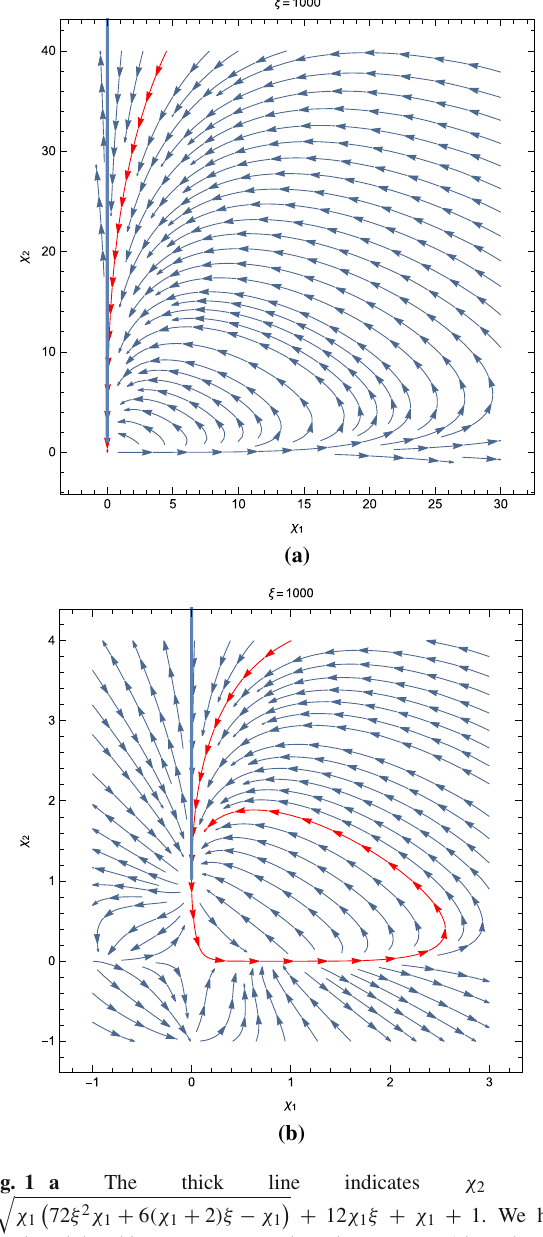
Fig. 1 a The thick line indicates χ 2 = (cid:8) (cid:4) (cid:5) χ ξ + χ + 1. We have + 12 χ + 72 ξ 2 χ 1 + 6 (χ 1 + 2 )ξ − χ 1 1 1 1 mentioned that this curve corresponds to the w ef f = − 1 boundary. As the calculations show, the field flow asymptotically becomes tangent to this line. This graph confirms the de Sitter as a transient attractor path for phantoms. b The smaller scales of χ 1 and χ 2 phase portrait with more resolution in numerical calculations reveals more details. The flows depart from the de Sitter line which ends at (χ 1 = 0 ,χ 2 = 1 ) entering ordinary region then passing the local maximum at φ = 0 (χ = 0 ) . Afterwards, another oscillation begins conducting the 2 trajectory towards the return point (χ 1 = 0 ,χ 2 = 1 ) . In simulations one can achieve more oscillations by cascading several numerical calculations, assuming the higher derivatives or approximating the vicinity of extrema. Without the (p)reheating outgoing energy channel, we do not expect the oscillations to imitate the early universe behavior completely, although it is enough for our purpose to distinguish oscillatory phase at the end of the de Sitter